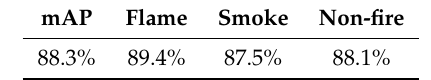
Table 2. Mean Average Precision (mAP) of Faster R-CNN.